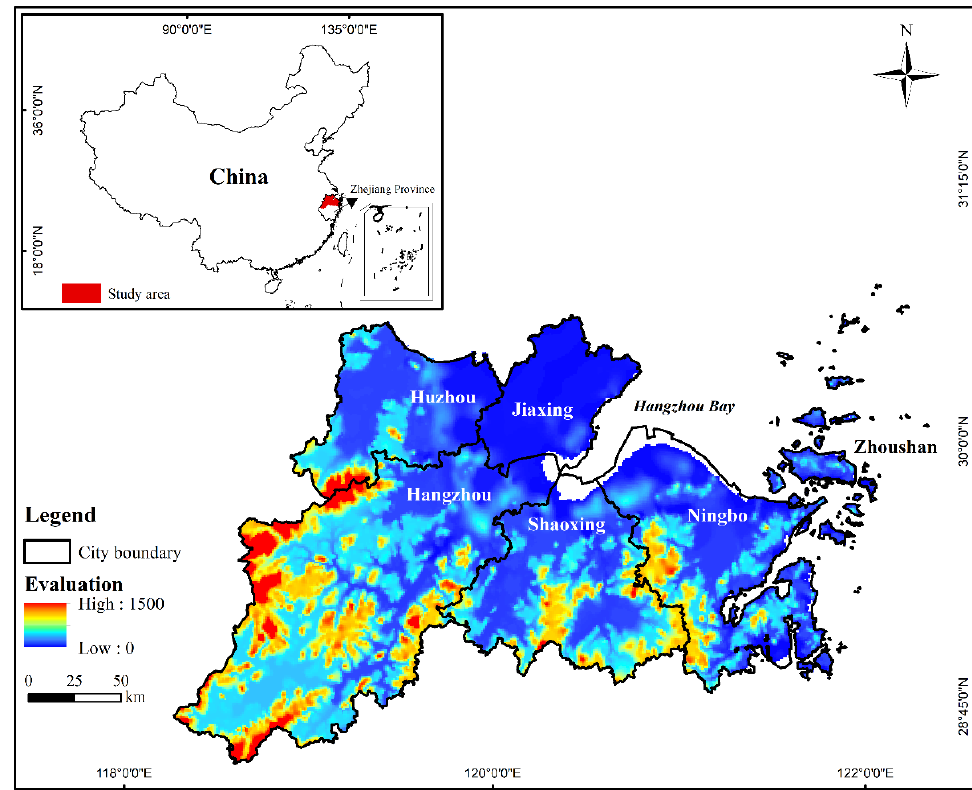
Figure 2. The location of the study area.